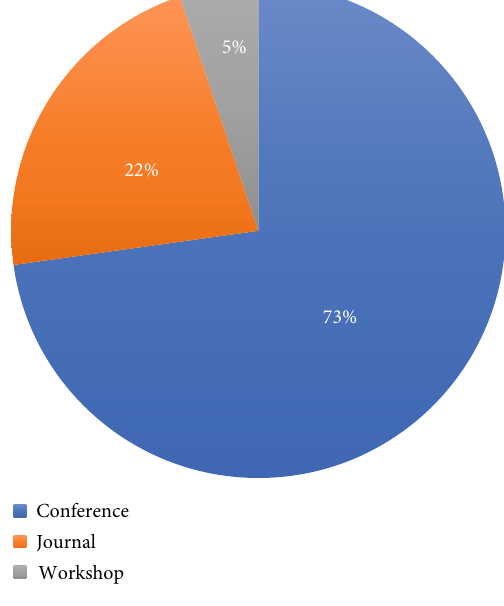
Figure 5: Types of